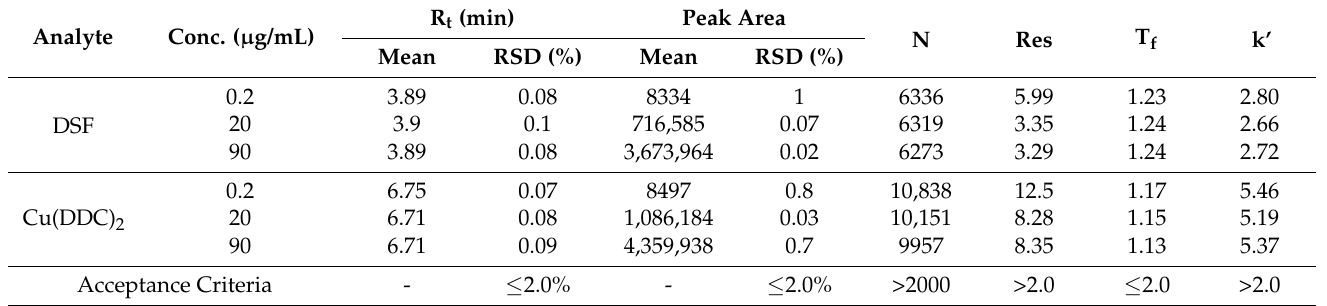
Table 6. System suitability testing, considering the reinjection of quality control samples (n = 6).